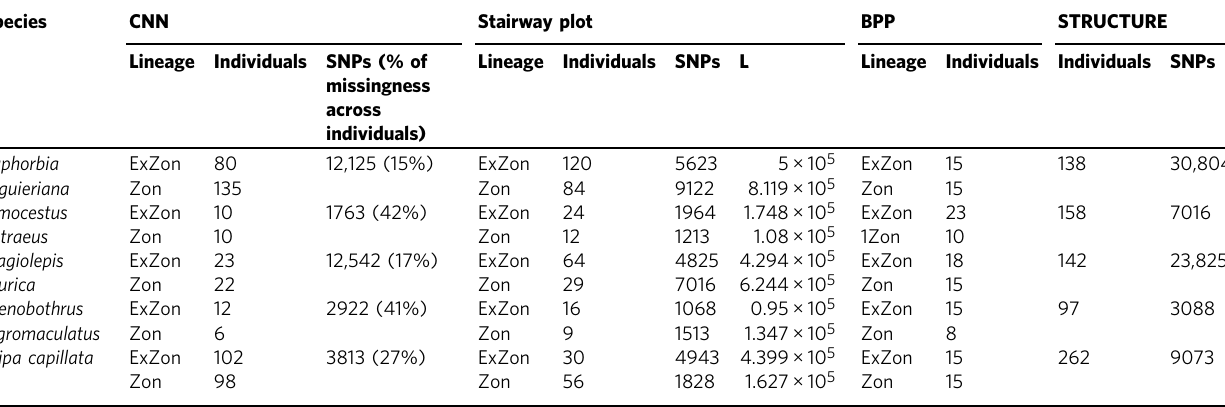
Table 1 Overview of the number of individuals (CNN, Stairway Plot, BPP, and STRUCTURE) and the number of single nucleotide polymorphisms (SNPs; CNN, Stairway Plot, STRUCTURE) used for the respective analysis and for each species (details in “ Methods ”